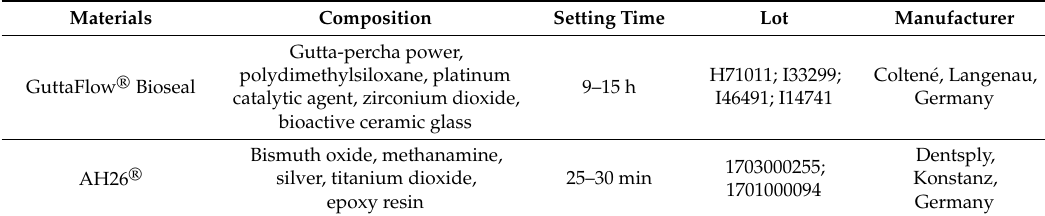
Table 1. Materials composition, setting times, lot, and